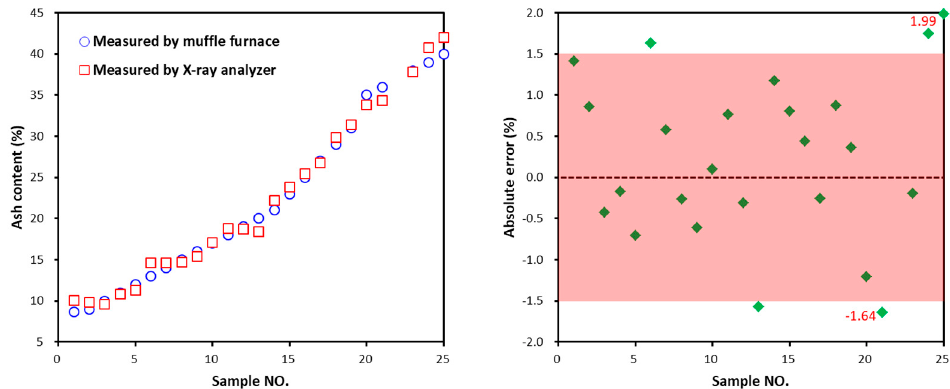
Figure 6. The difference ( left ) and absolute error ( right ) between the ash contents measured by muffle furnace and X-ray analyzer for slack coal with ash content between 8.63% and 40%.